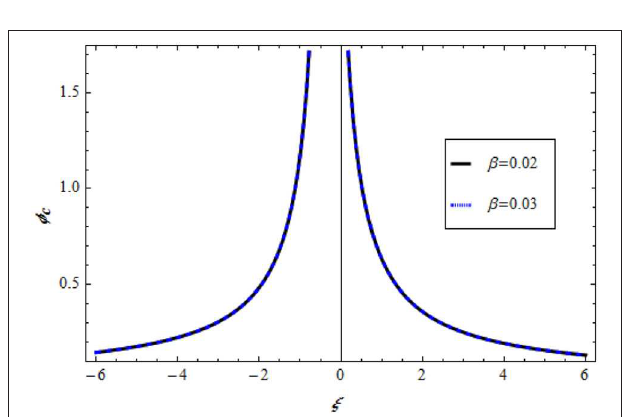
0.02, u 0.02, v 0.5, = = =